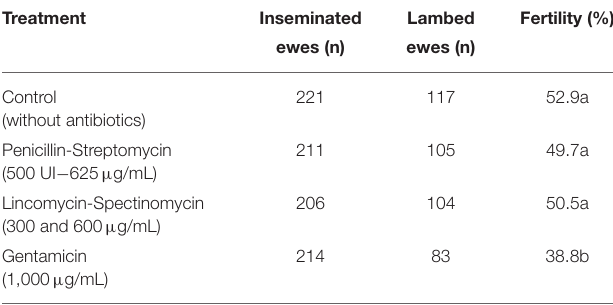
TABLE 1 | Fertility results (lambed ewe/100 inseminated ewe) by treatment as follows: Control (without antibiotics), Penicillin-Streptomycin; with Penicillin (500 UI) and Streptomycin to a final concentration of 625 µ g/mL; Lincomycin-Spectinomycin to a final concentration of 300 and 600 µ g/mL, respectively; and Gentamicin to a final concentration of 1,000 µ g/mL.